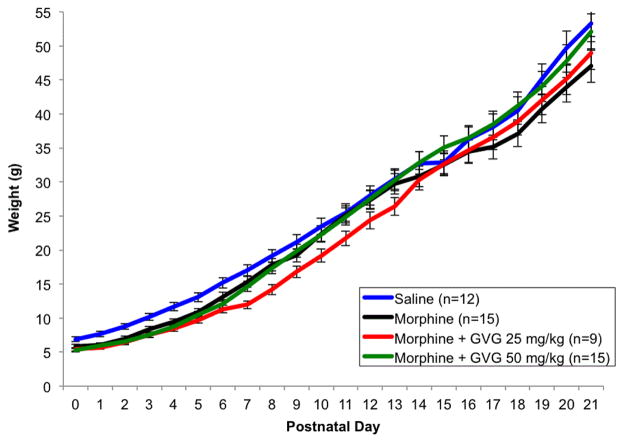
Average pup weight gain over time, Average daily pup weight up to PND 21. Birth weights from morphine, morphine +GVG25 and morphine+GVG50 treatment groups were significantly lower than control pups (p<0.01). However, by PND 21, weights of the morphine+GVG25 (p=0.90) and morphine +GVG50 groups (p=0.49) returned to control values while pup weights exposed to morphine alone did not (p=0.01).